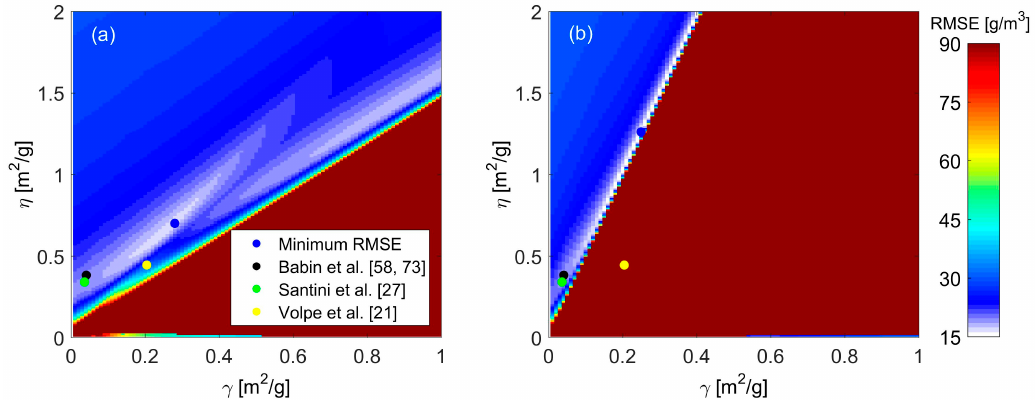
Figure 5. Root-mean-square-error (RMSE) of the SSC calibration as a function of the suspended sediment specific absorption ( γ ) and backscattering ( η ) coefficients at around 400 nm using Hyperion bands centered at ( a ) 660 nm (seven spectral bands from 630 nm to 690 nm), and ( b ) 560 nm (nine spectral bands ranging from 520 nm to 600 nm). RMSE values are color-coded based on the color bar legend. Table 3. Least root-mean-square-error (RMSE) obtained from the inversion of radiative transfer model (Equation (8)) with calibration and validation (see Section 2.5 for detail) using Hyperion data. Calibration RMSE (g/m 3 )